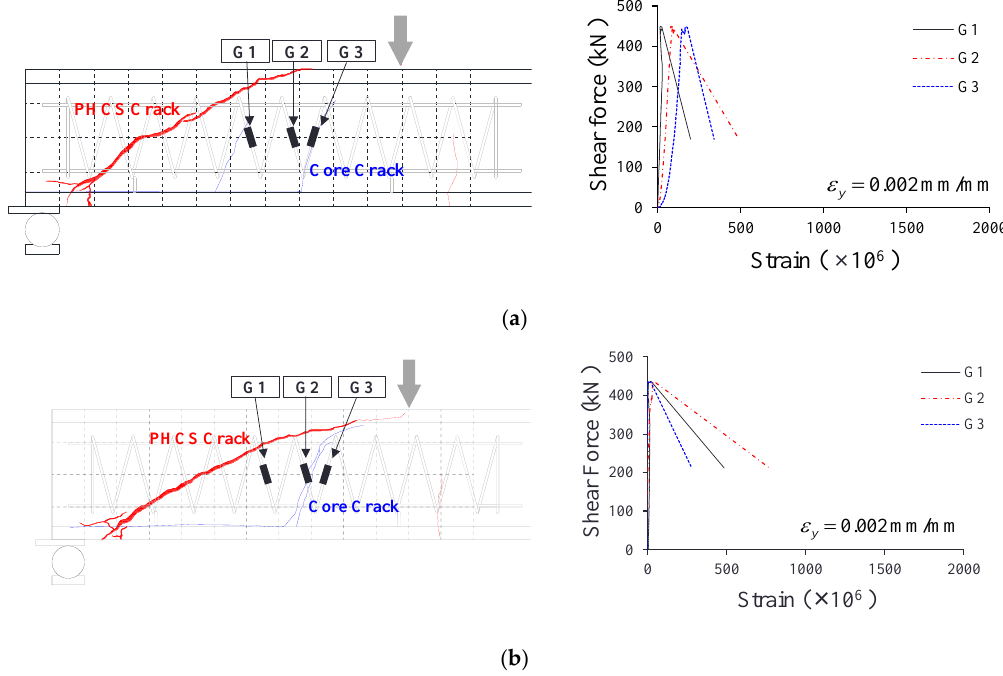
Figure 10. Measured strain from shear reinforcement. ( a ) Measured strain from the LR-2/4 specimen. ( b ) Measured strain from the HR-2/4 specimen.